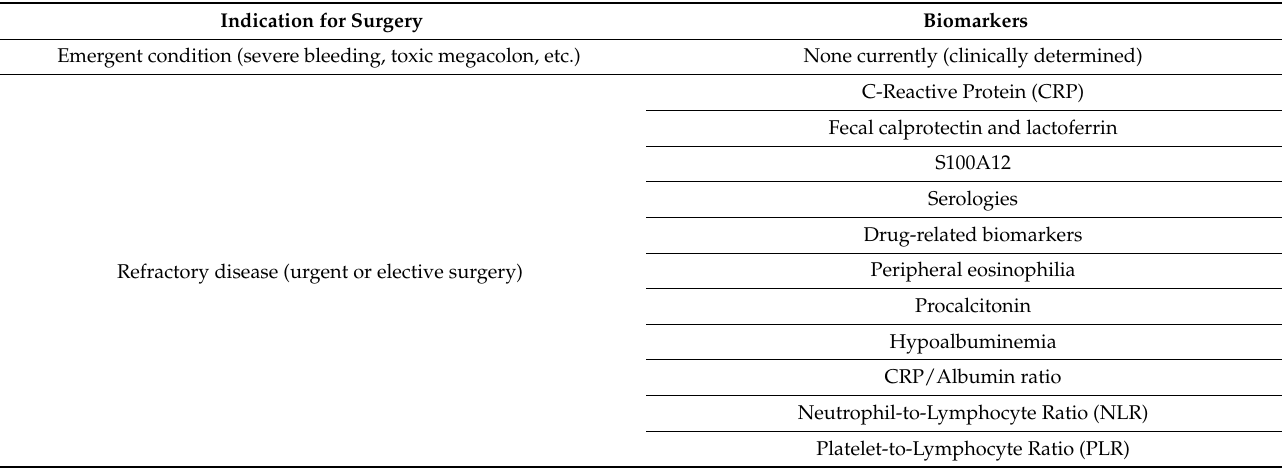
Table 1. Indications for surgery in ulcerative colitis and associated